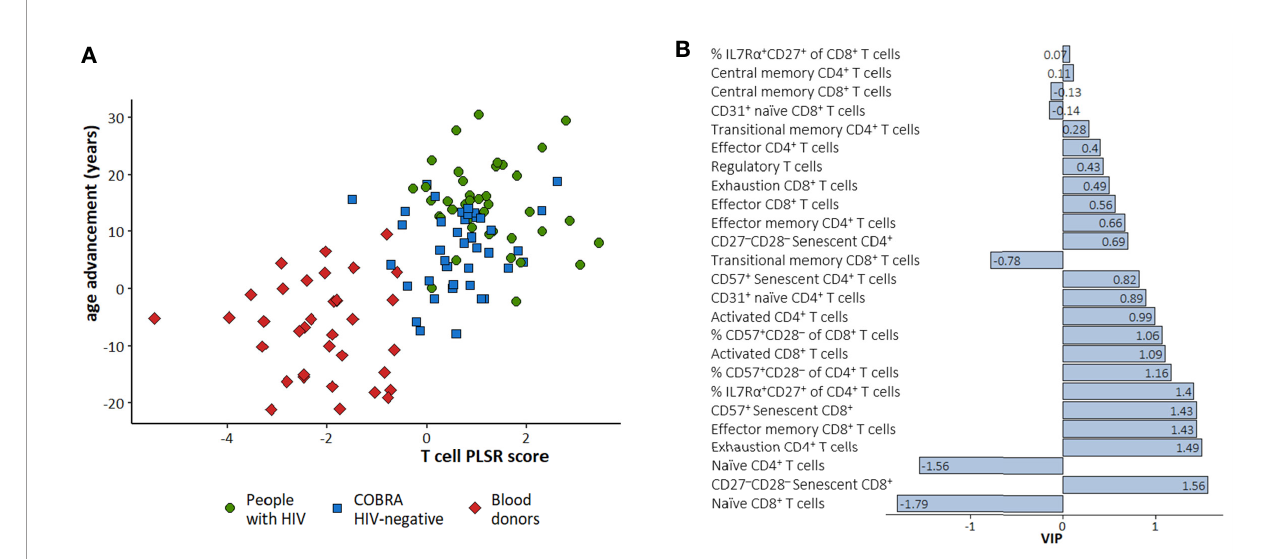
FIGURE 4 | Partial least squares regression (PLSR) to predict age advancement with T cell markers in the three study groups combined. (A) Scatter plot of the PLSR score obtained and age advancement. Green circle: People with HIV; Bleu square: COBRA HIV-negative individuals; Red diamond: Blood donors. (B) VIP values for each T cell marker. A negative VIP indicates that decreased levels of the speci fi c marker is associated with increased age advancement. A positive Variable Importance in Projection (VIP) indicates that increased levels of the speci fi c markers is associated with increased age